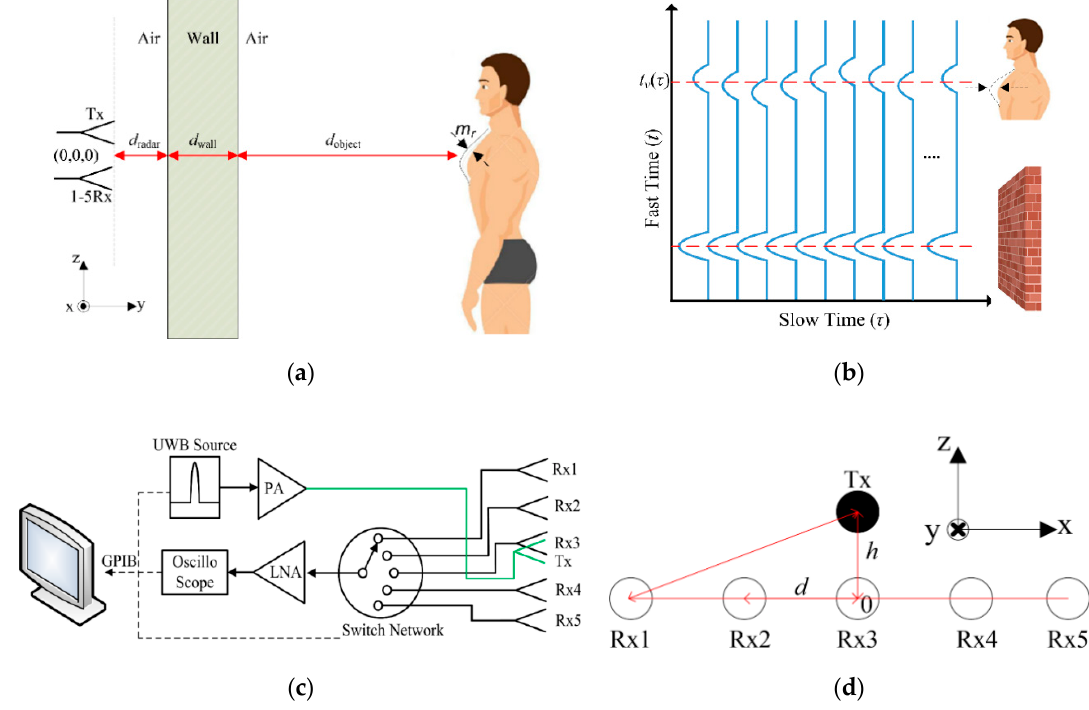
Figure 4. Principle of the through-the-wall ultra-wideband (UWB) radar: ( a ) round-trip Tx and Rx signals with human object; ( b ) raw data per channel; ( c ) block diagram of the 1-Tx/5-Rx UWB switched-antenna-array radar; ( d ) 1-Tx/5-Rx antennas arrangement with Rx3 at the origin.